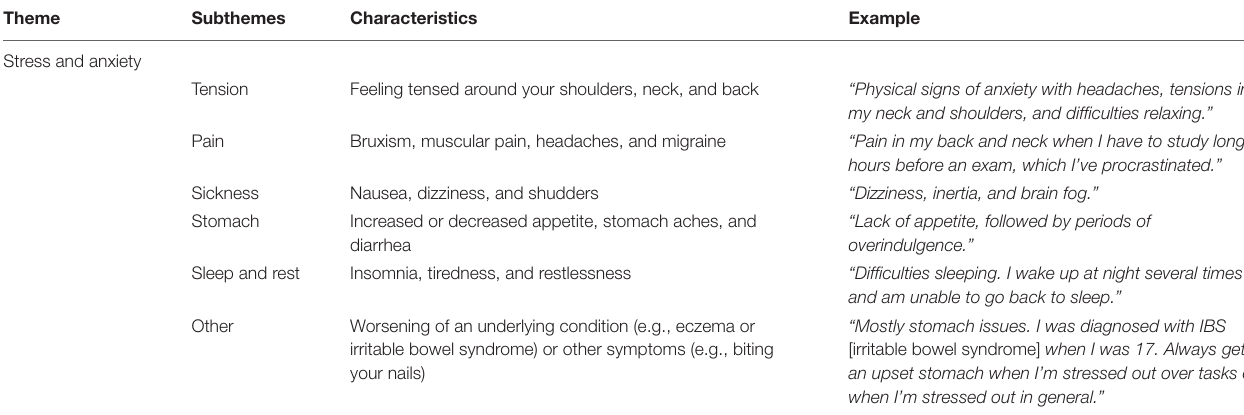
TABLE 5 | Physical issues of